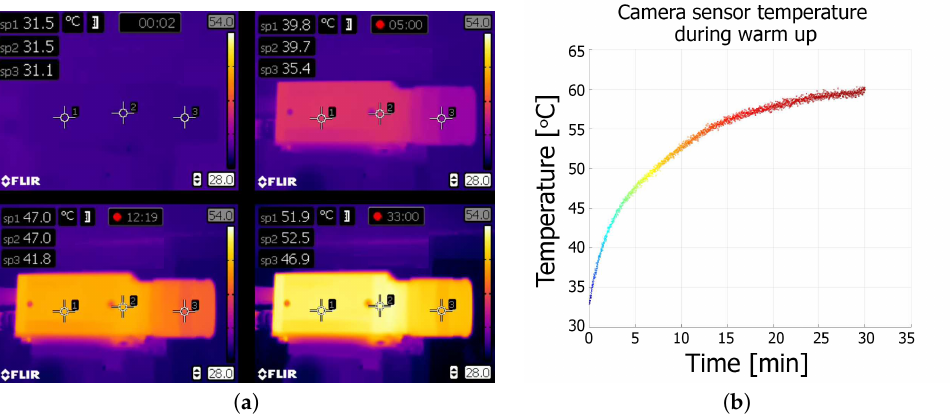
Figure 3. The warm-up effect of the tested camera. ( a ) The distribution of temperature on the surface of the tested camera (PointGrey Grasshopper2) and lens (Fujinon HF25SA1B) observed with a thermal imaging camera. ( b ) The temperature measured by the camera sensor as a function of